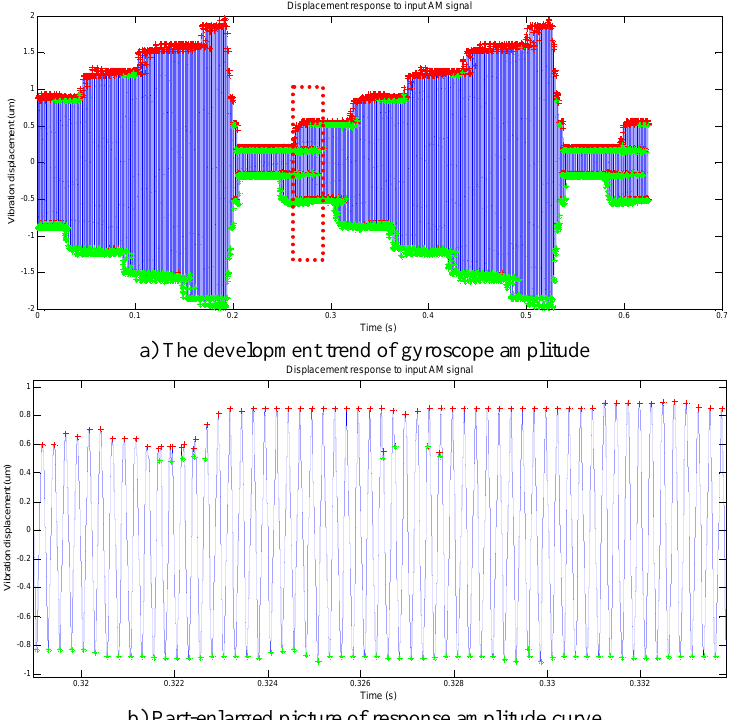
Fig.4 displacement response to input signal obtained by